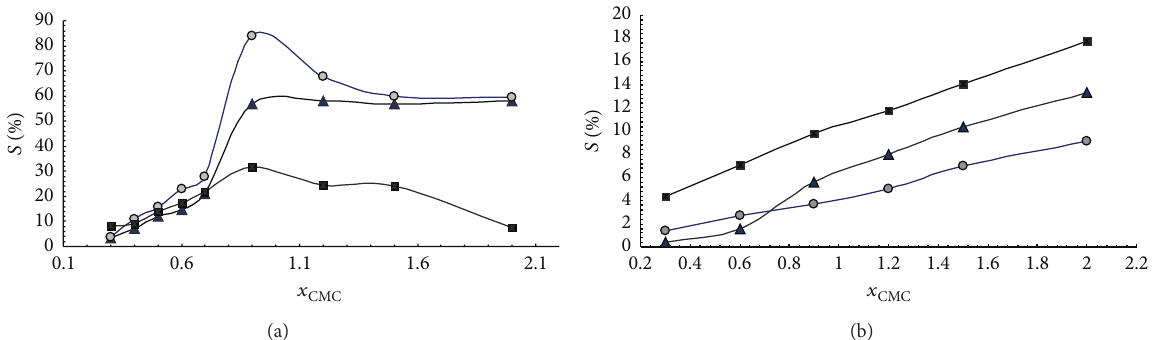
Figure 2: Solubilization curves (median values) resveratrol (4 mM) in presence of (a) sodium 3 𝛼 ,12 𝛼 -dihydroxy-7-oxo-5 𝛽 -cholanoate and (b) sodium dodecyl sulfate (black triangle: surfactant, pH 8.00 phosphate buffer; grey circle: surfactant + 0.3 M NaCl, pH 8.00 phosphate buffer; black square: surfactant + 2 M urea, pH 8.00 phosphate buffer.